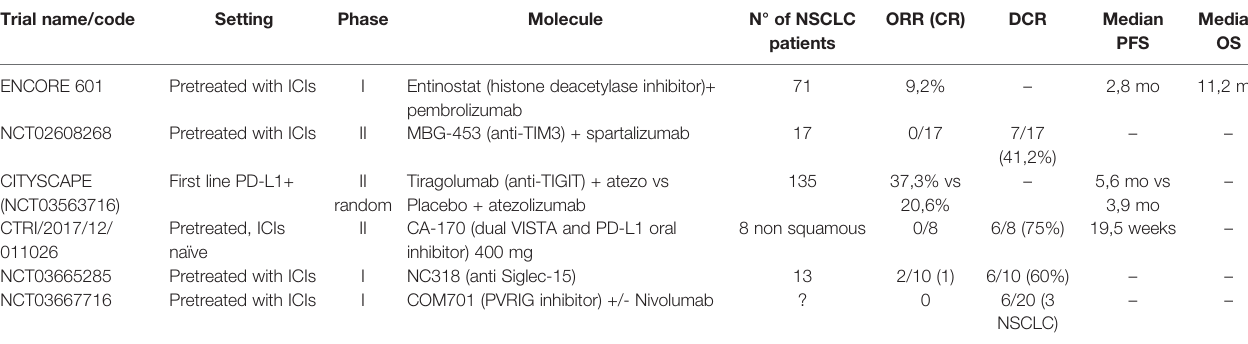
TABLE 1 | Results of clinical trial for new agents targeting co-inhibitory signals on T cells and epigenetic